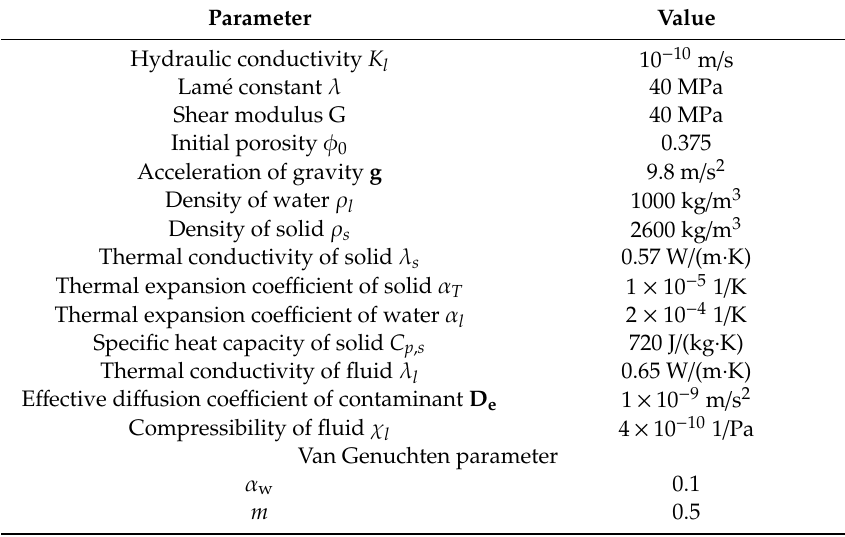
Table 1. Parameters for numerical simulations.